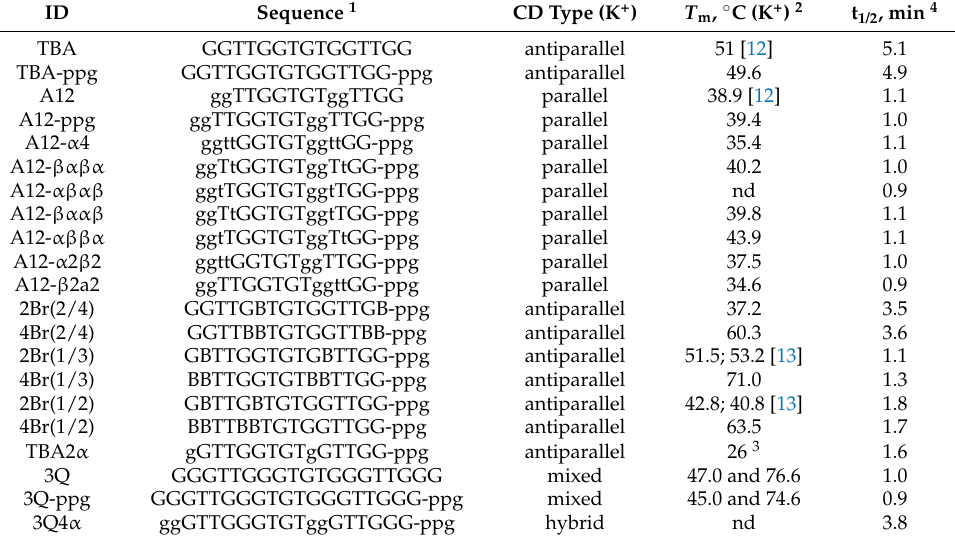
Table 1. Modified TBA